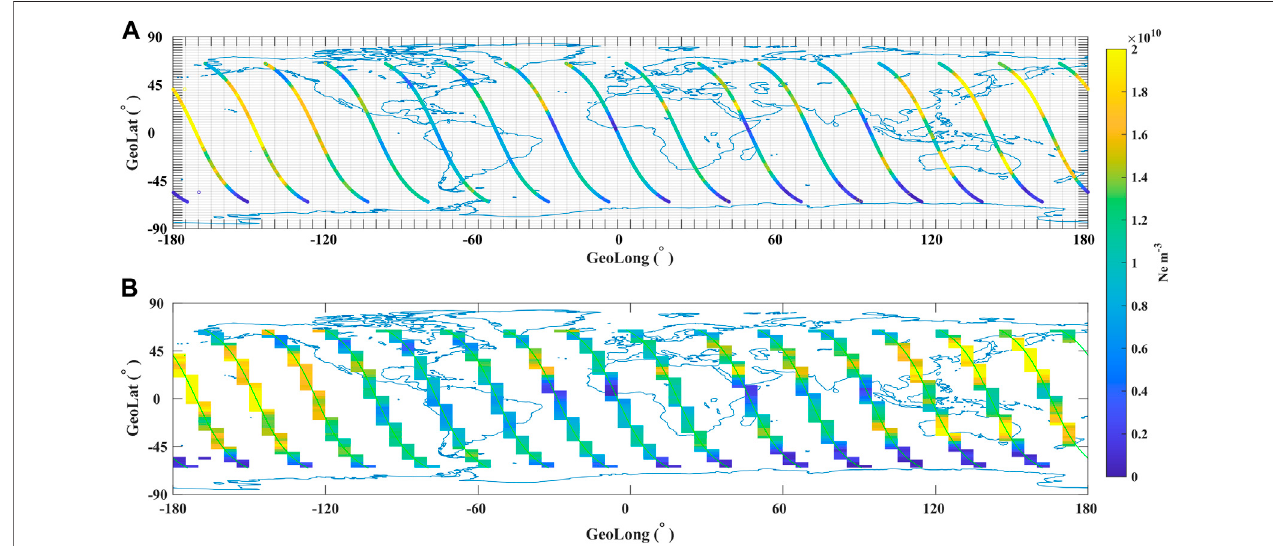
FIGURE 1 | Ne distribution of global data in the nighttime on 28 July 2018 from CSES. (A) Raw data along the orbits and the 2.5 ° (latitude)×5 ° (longitude) cells. (B) Median values in each cell, which is utilized to exhibit the Ne distribution in 1 day.